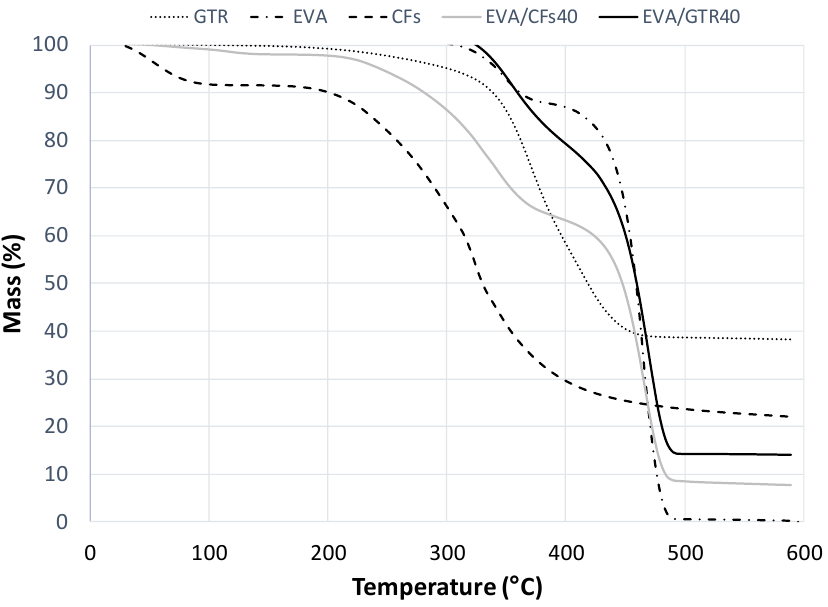
Figure 8. Thermograms of EVA/GTR and EVA/CFs composites at 40% composition and their corresponding components separately (EVA, GTR and CFs).